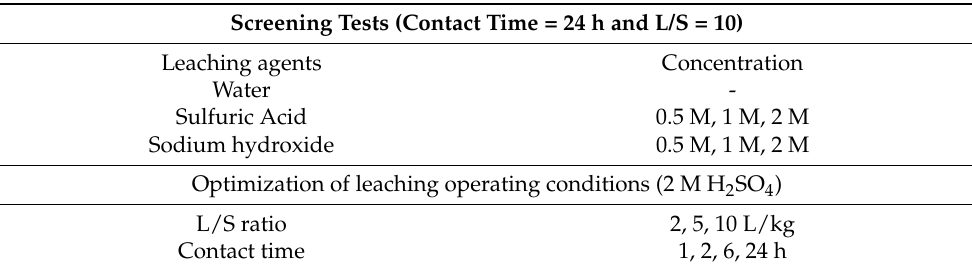
Table 2. Leaching tests carried out in stages 1 and